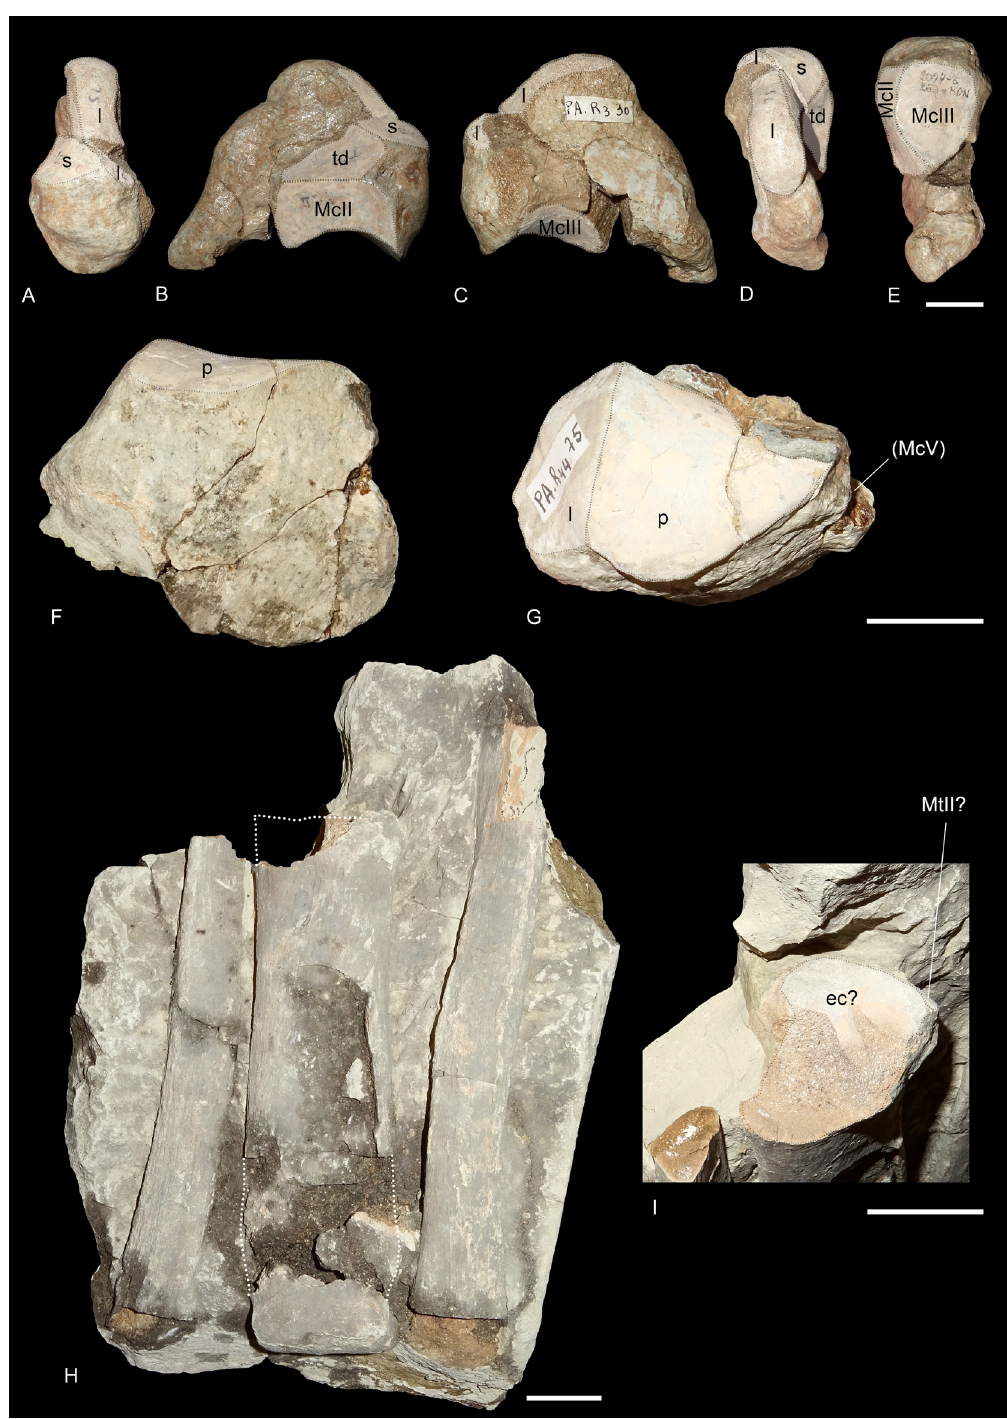
Fig. 5. Ronzotherium velaunum (Aymard in Pictet, 1853) from Ronzon (earliest Oligocene, France). – A–E . Left magnum PUY.2004.6.263.RON. A . Anterior view. B . Medial view. C . Lateral view. D . Proximal view. E . Distal view. – F–G . Left unciform PUY.2004.6.1480.RON. F . Anterior view. G . Proximal view. – H–I . Central metapodial PUY.2004.6.840.RON (possibly a MtIII) on sedimentary block, along with two probable ribs on its right and left. H . Anterior view. I . Close-up view of the proximal extremity. Abbreviations: ec = ectocuneiform; l = lunate; p = pyramidal; s = scaphoid; td = trapezoid. Articular surfaces highlighted in white. Scale bars: 2